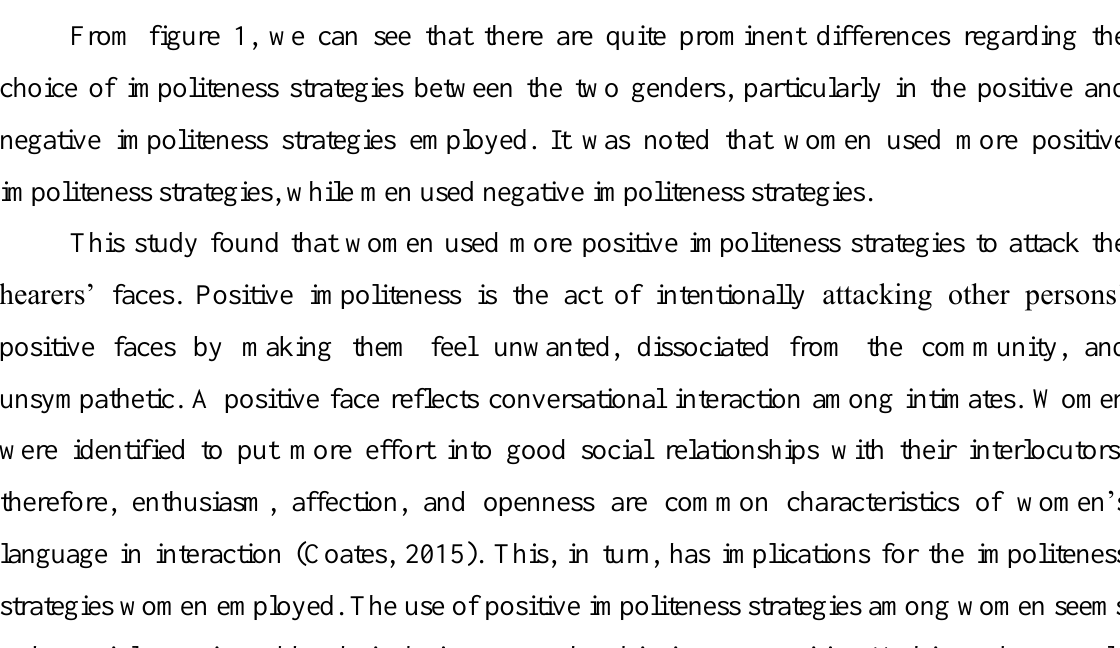
Figure1. Impoliteness Strategies Used by Main Female Character (Nadine) and her Male